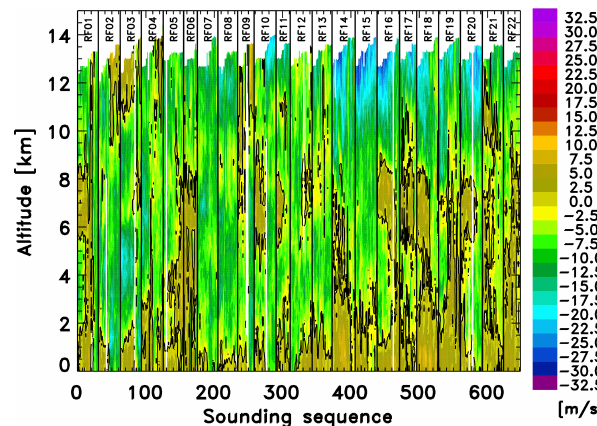
Figure 9. Color contours for all temperature measurements. Miss- ing data are shown in white. All soundings are shown in the se- quence in which they were released. Vertical lines separate the re- search flights, which are indicated in each group.